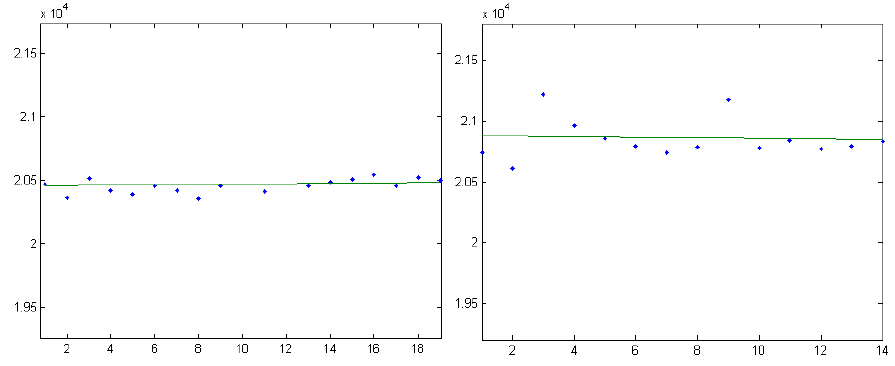
Figure 16. Measurement results for the observed GPS satellites, in the SAO54449 sky area. PRN 10, left, and PRN 8, right.